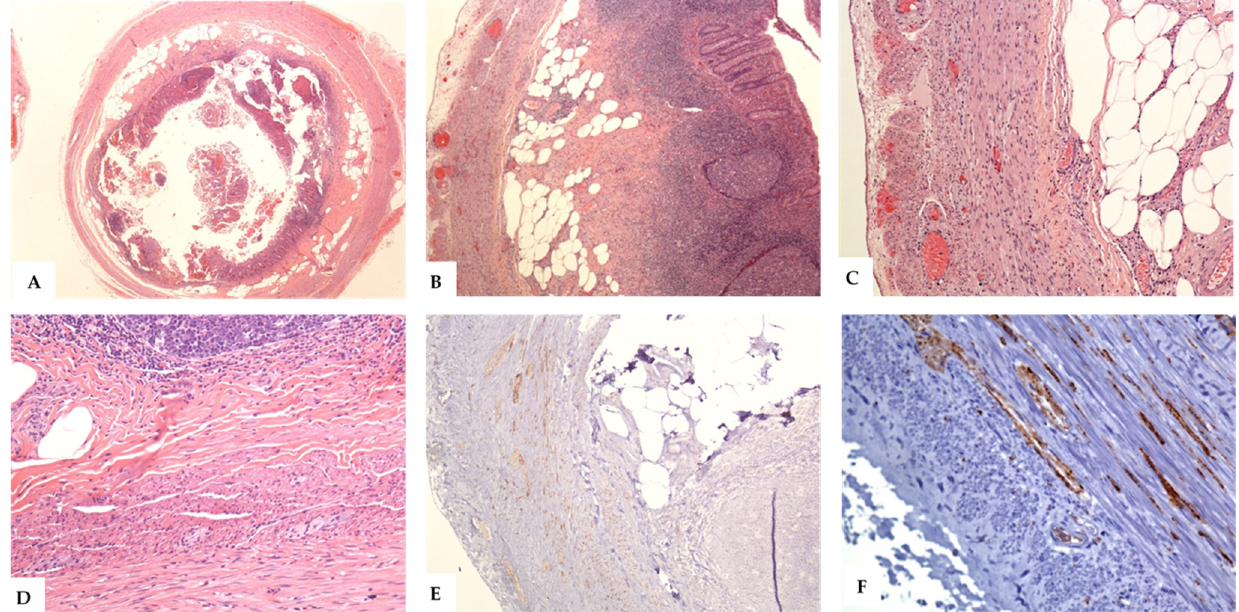
Figure 4. The histological features of the intramucosal variant of neurogenic appendicitis. ( A – D ): Sections from the appendix show intramucosal lesion with the patent lumen, destruction of the mucosal glands, and crypts expansion of the submucosa by residual lymphoid infiltrate, fibrous and neural tissues, and hypertrophied nerve bundles that extend into the mucosa. There are lob- ules of mature fat cells in the submucosa. The presence of lymphomononuclear cells is indicative of repeated attacks of minimal asymptomatic mucosal inflammation. No acute inflammatory cells are seen. There is no evidence of periappendicitis. ( E , F ): the hypertrophied never bundles and ganglion